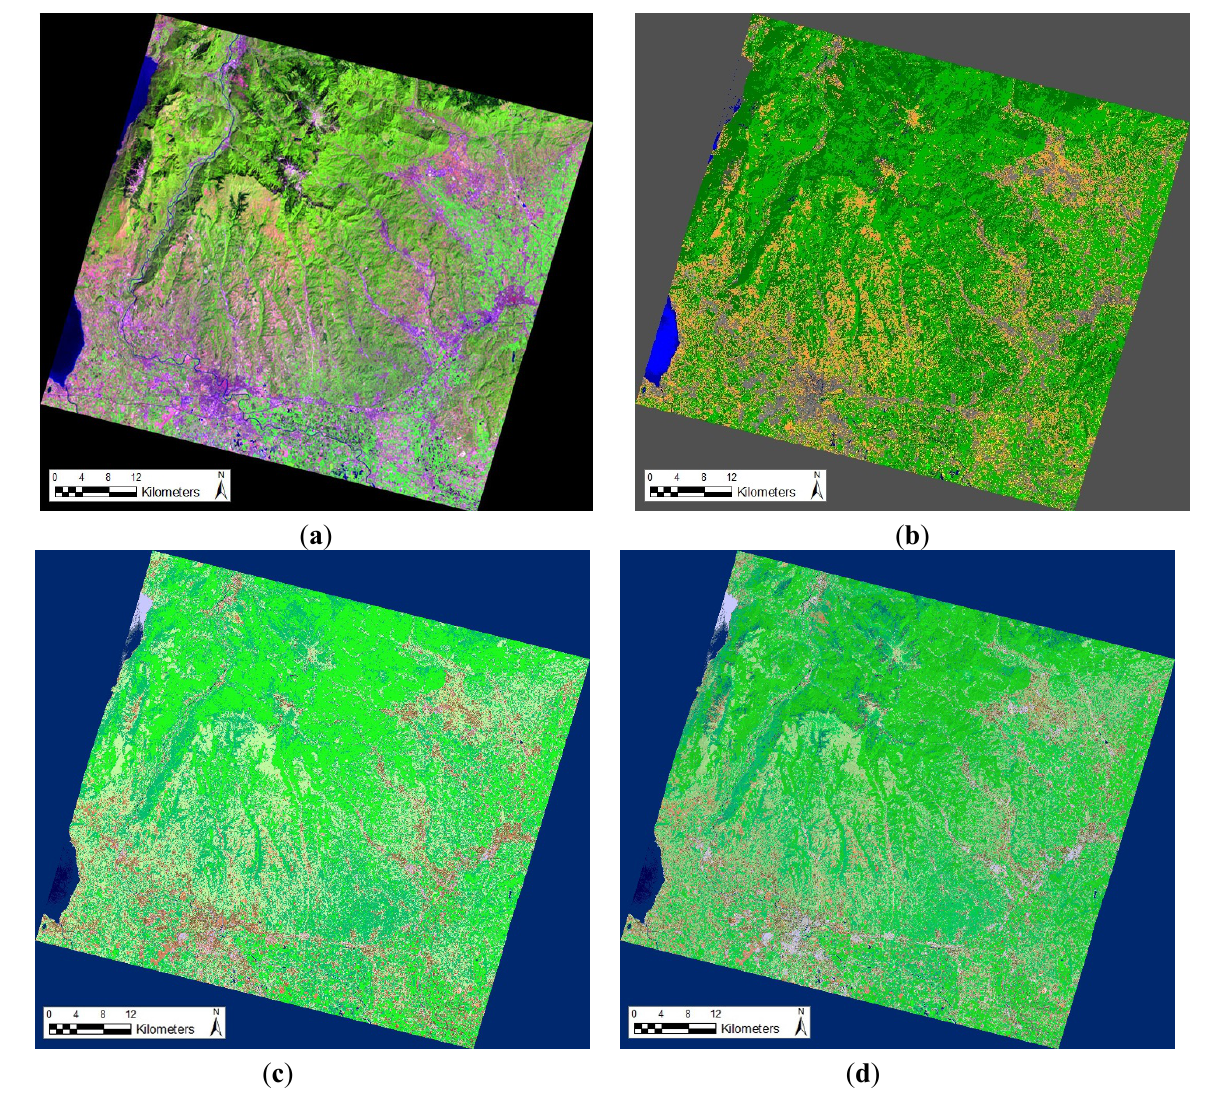
Digital Scanner (ADS)-80 image, acquired over an unknown location in the